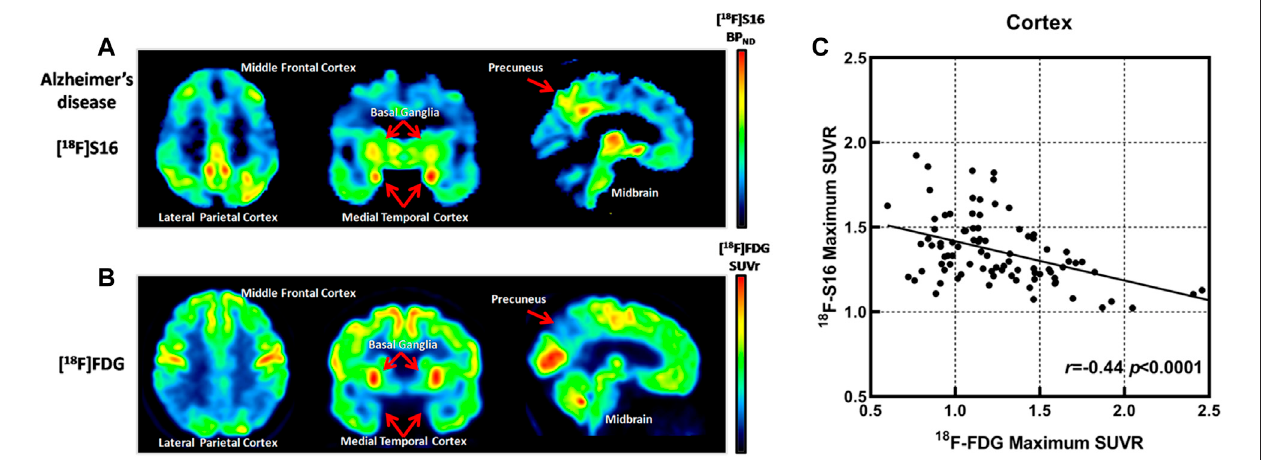
FIGURE 4 | Comparison of [ 18 F]-S16 BP ND positron emission tomography (PET) map and [ 18 F]-FDG SUVR PET map obtained in the same Alzheimer ’ s disease patient (subject 6). The images were normalized to the Montreal Neurologic Institute space and presented as a transverse, coronal, and sagittal plane (A,B) . Correlation plots for [ 18 F]-S16 and [ 18 F]-FDG PET. r = − 0.44, p < 0.0001 (C)